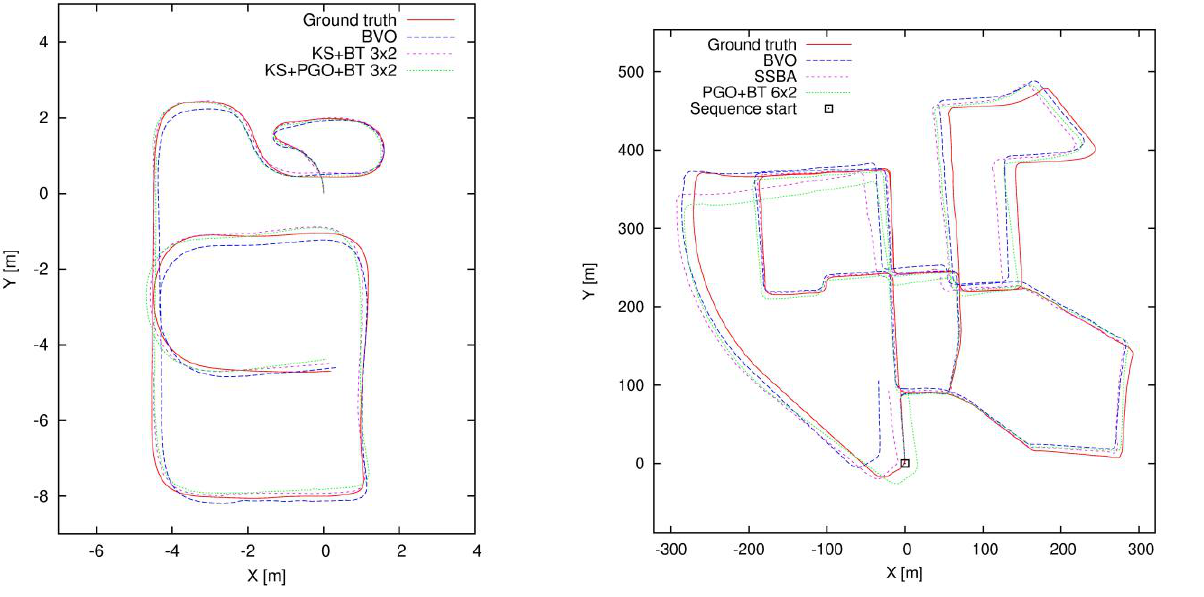
Figure 4. Selected result trajectories for